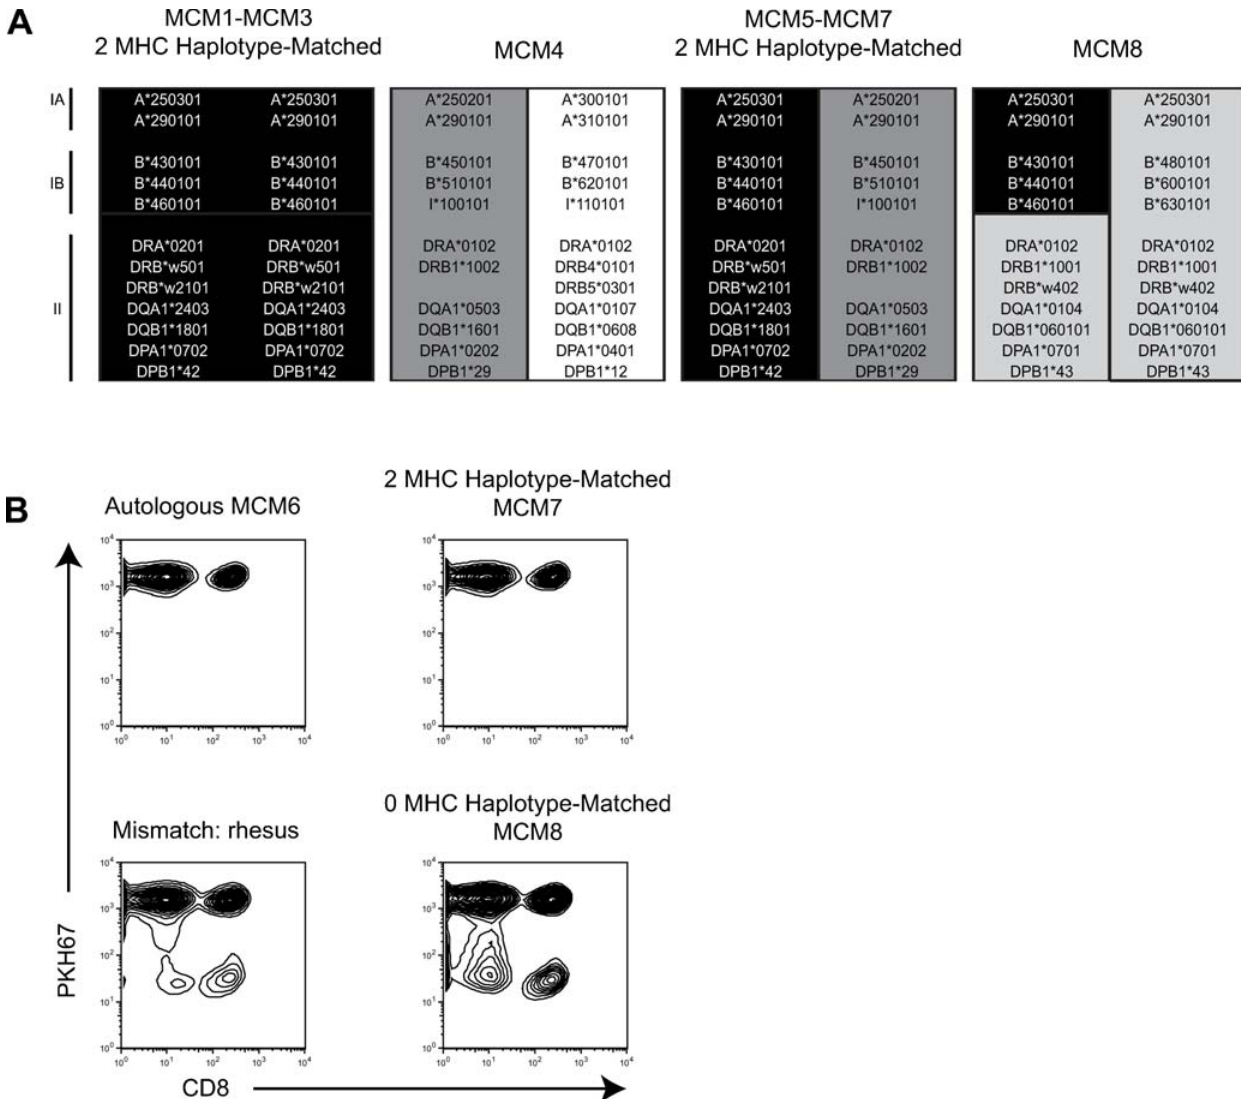
Figure 1. Invitro histocompatibility of MHC-matched MCM . A Microsatellite analysis was used to identify 2-MHC-haplotype-matched, 1-MHC- haplotype-matched, and 0-MHC-haplotype-matched MCM. MHC haplotypes inferred by microsatellite typing [35] are colored to show matching between individuals. Predicted MHC class I and class II alleles for each haplotype are shown. We identified 8 MCM for use in these experiments. B Results from mixed lymphocyte reactions. Whole PBMC from MCM6 was labelled with fluorescent dye PKH67 and incubated with irradiated stimulator cells as indicated above each plot. Cells that divide after recognizing non-self antigen lose fluorescence as indicated by a decrease along the y-axis. Dot plots are gated on lymphocytes according to forward and side